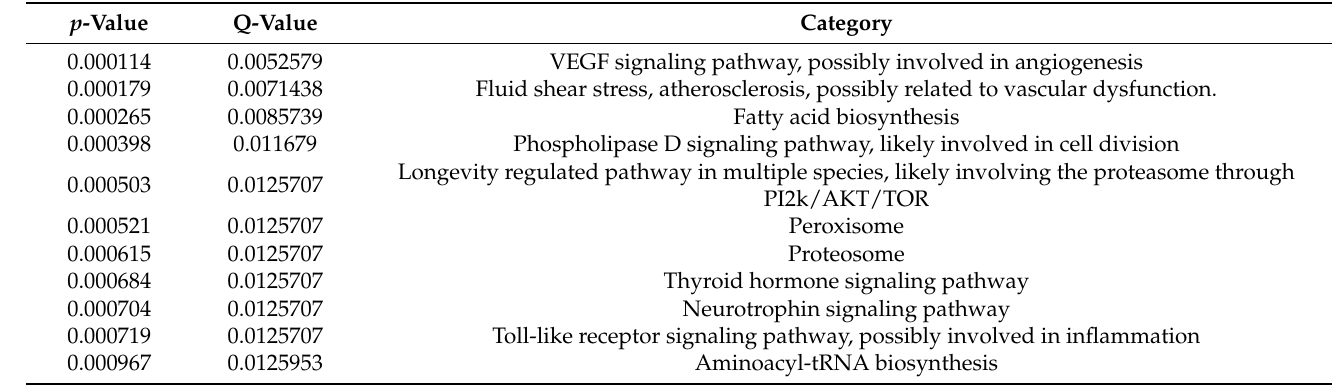
Table 3. Putative pathways affected by significantly altered miRNAs.